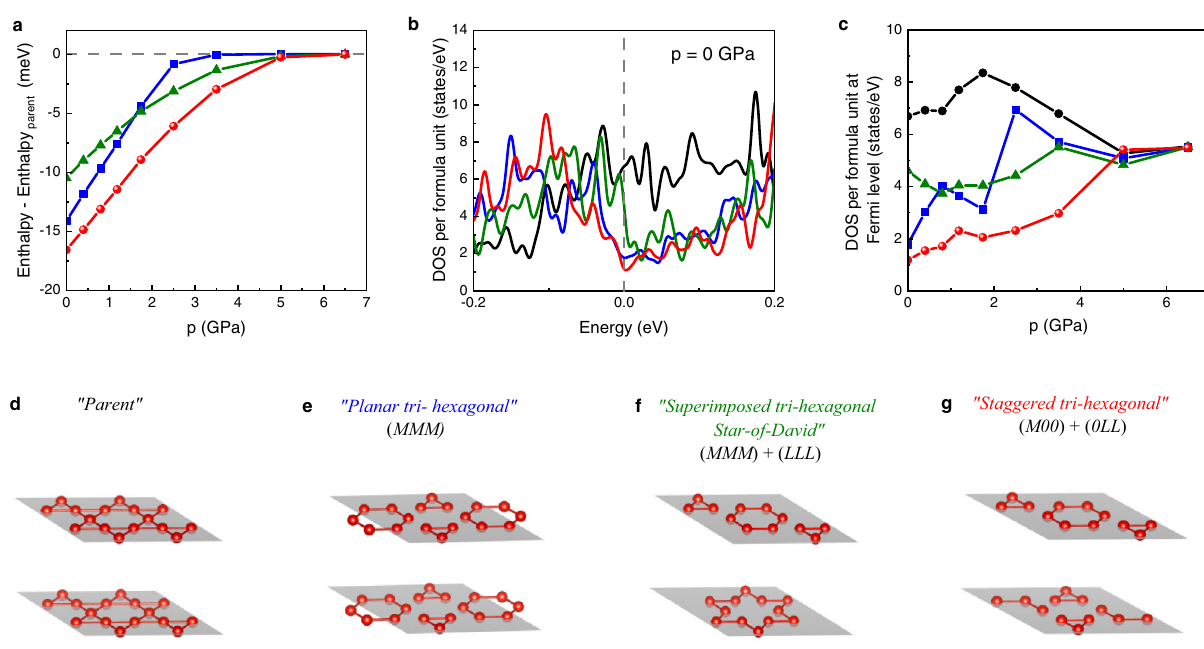
Fig. 4 Theoretical modeling and density functional theory results. a Pressure dependence of the difference in enthalpies between a charge-ordered state and that of the undistorted kagome lattice for different possible CO phases discussed in the text and shown in e – g . b Density of states (DOS) per formula unit calculated at ambient pressure for the different CO phases considered. c Variation of the DOS per formula unit at the Fermi level with pressure. The distinct types of CO states considered here display different bond order con fi gurations and are named: d parent; e planar tri-hexagonal; f superimposed tri- hexagonal Star-of-David; and g staggered tri-hexagonal. Black, blue, green and red points in a – c correspond to these CO con fi gurations